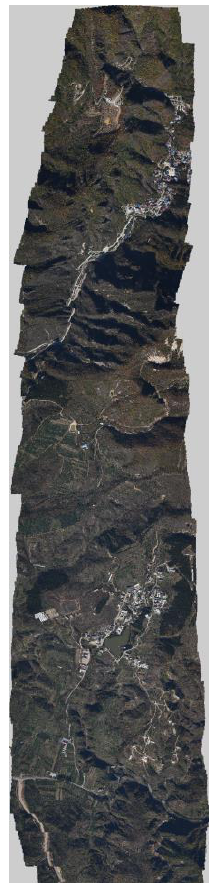
Figure 13. The dynamically generated